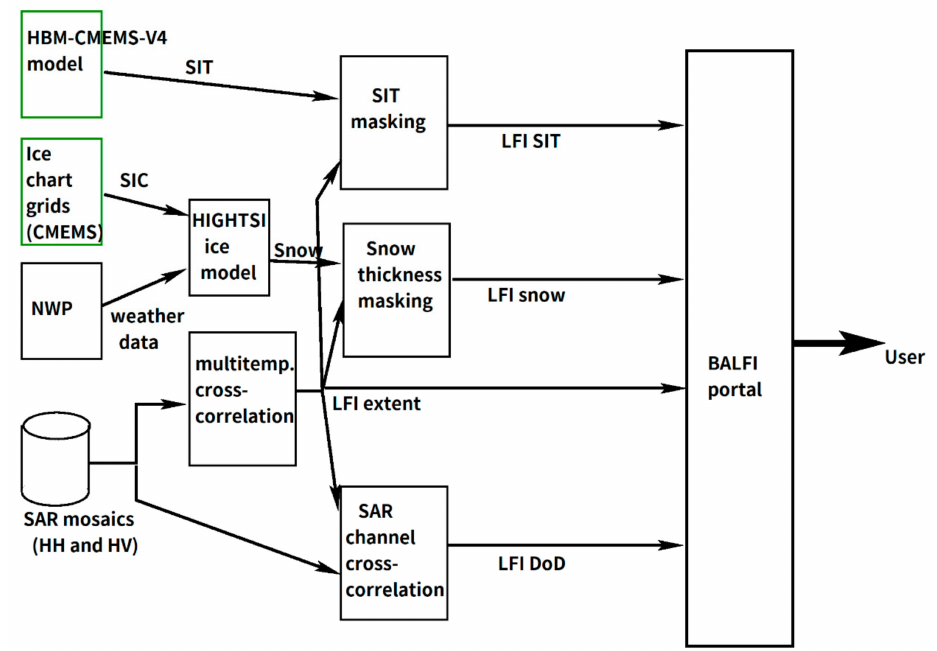
Figure 5. Schematic production chain of the Baltic Sea landfast ice extent and thickness (BALFI) products. For details see the text. Green boxes show the Copernicus Marine Environment Monitoring Service (CMEMS) Baltic Sea